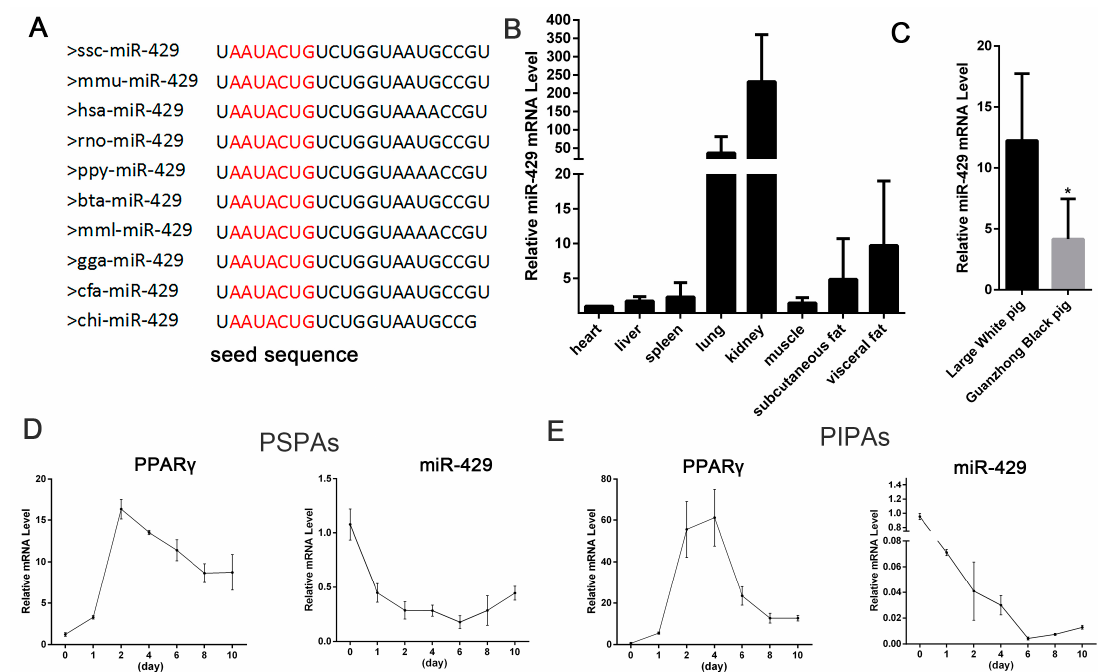
Figure 1. miR-429 tissue distribution and expression patterns during porcine preadipocyte differentiation. ( A ) Mature miR-429 sequence was highly conserved among species; ( B ) miR-429 expression was detected in 8 different tissues of 180-day Large White pig; ( C ) RT-qPCR detected the miR-429 expression in subcutaneous adipose tissue of 180-day Large White and Guanzhong Black pigs. PPAR γ and miR-429 expression pattern during differentiation of PSPAs ( D ) and PIPAs ( E ). Results are indicated as means ± SEM; n = 3; * p < 0.05. PSPAs, porcine subcutaneous pre-adipocytes; PIPAs, porcine intramuscular pre-adipocytes.